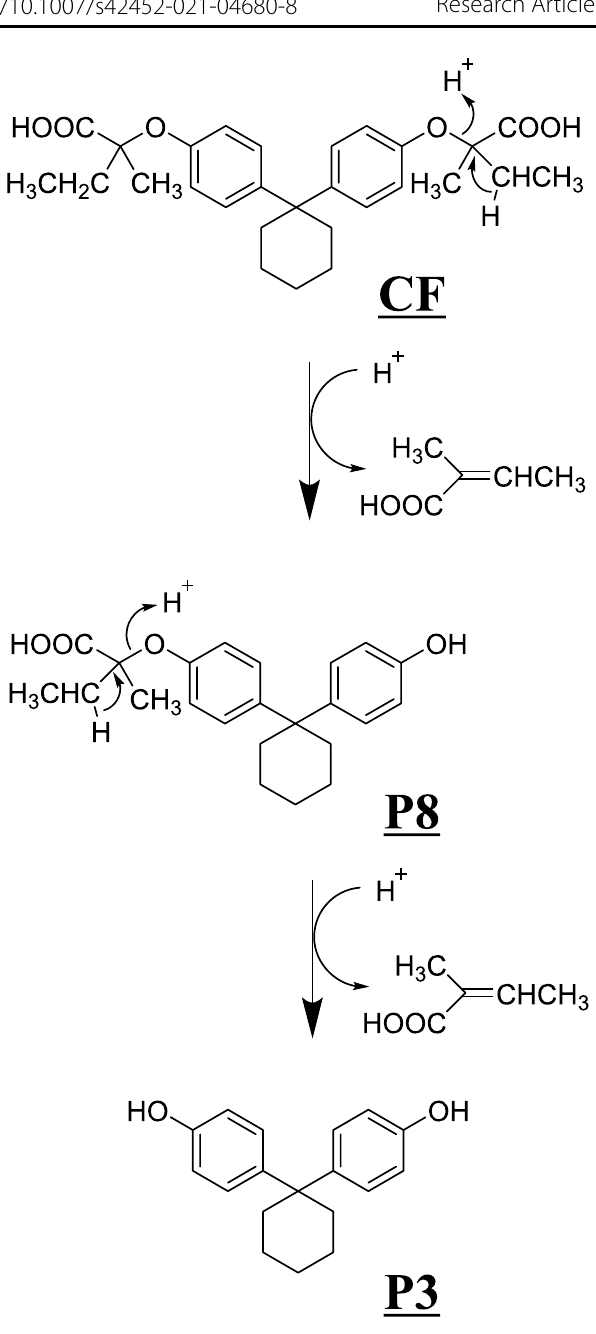
Fig. 4 Proposed photodegradation pathways for P3 and P8 from